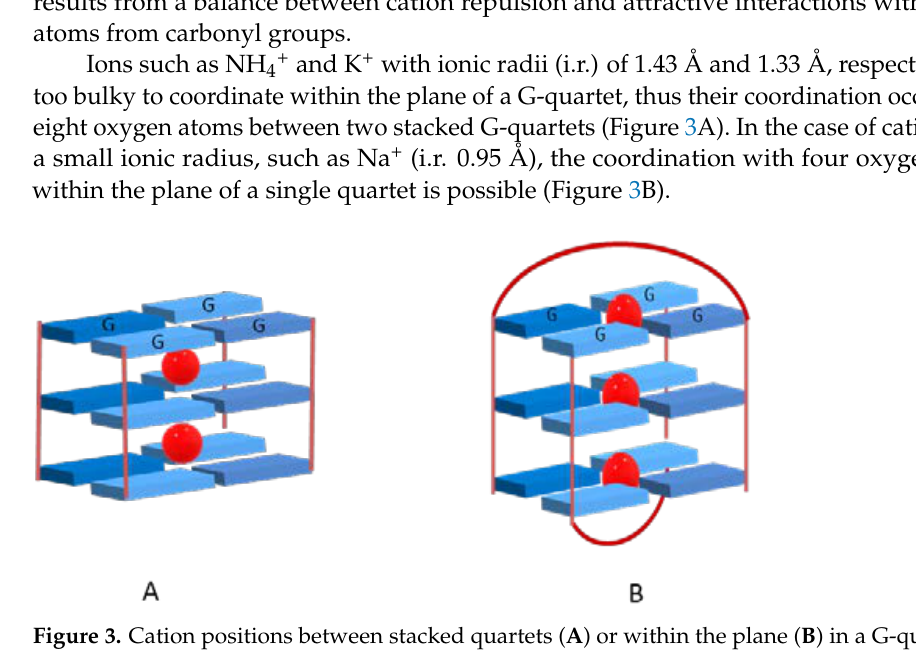
Figure 4. ( A ) Different conformations assumed by G-quadruplexes structures depending on strand orientation and ( B ) possible loop geometries. The relative strand orientation also influence the glycosidic bond angle of the gua- nines involved in the quartets that can assume an anti and/or syn geometry (Figure 5). A combination of syn and anti geometries is observed for antiparallel and hybrid structures, while parallel topologies contain almost exclusively anti geometry (Figure 5) [15,16].